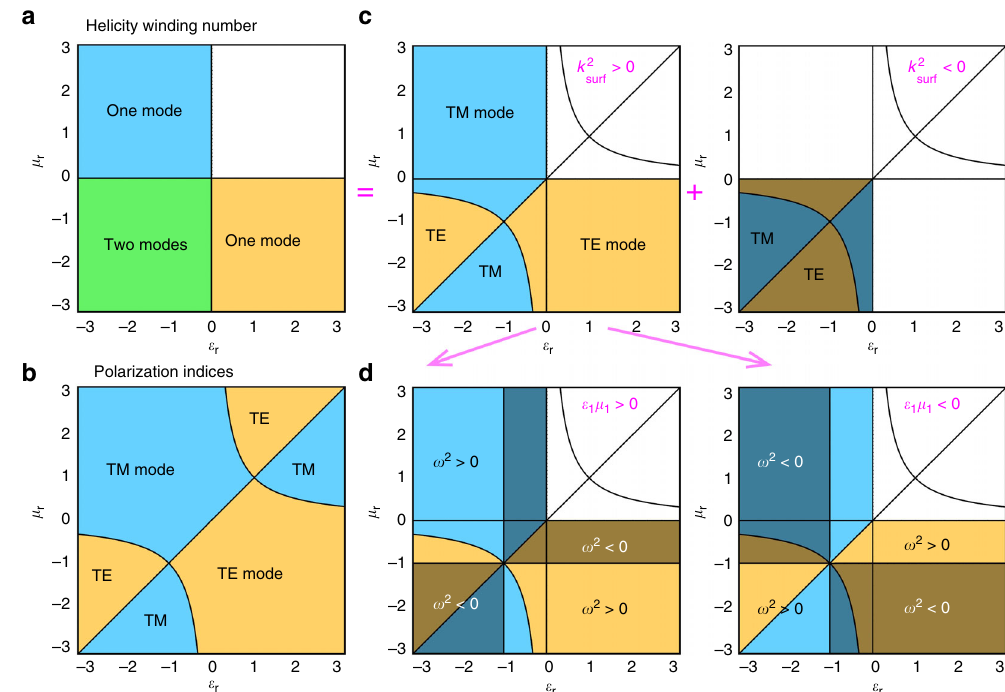
Fig. 3 Phase diagrams of surface Maxwell waves. a Zones of the existence of zero, one, and two surface zero-helicity modes described by the topological helicity winding number Eq. (3) and the bulk-boundary correspondences Eqs. (4) and (5), see Fig. 2b. b Phase separation of the transverse-electric (TE) and transverse-magnetic (TM) modes described by the polarization indices Eq. (8). c The phase diagrams resulting from the combination of a and b . The two-mode quadrant ( ε r < 0, μ r < 0) has both TE and TM modes in every point, but only one of these is propagating (i.e., having real wavevector k the other one is evanescent (having imaginary k surf ). d Splitting the phase diagram ( c ) with real k surf into zones with real (bright areas) and imaginary (dark areas) frequency ω . These zones swap upon the inversion of the sign of the squared refractive index of the fi rst medium, n 2 surf